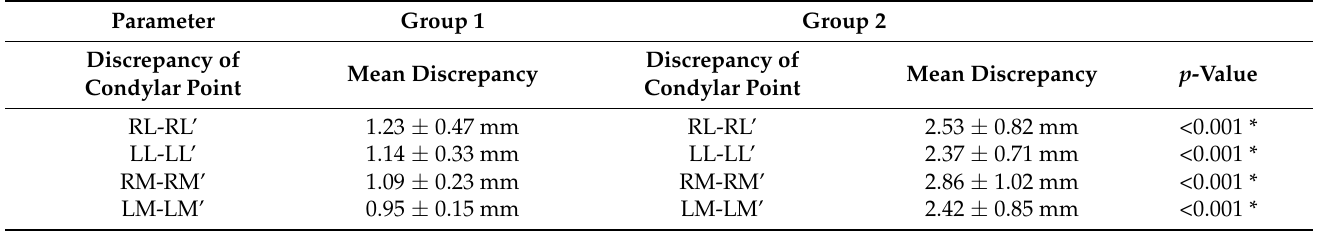
Table 3. Discrepancy of the most lateral and medial condylar points between the two groups.